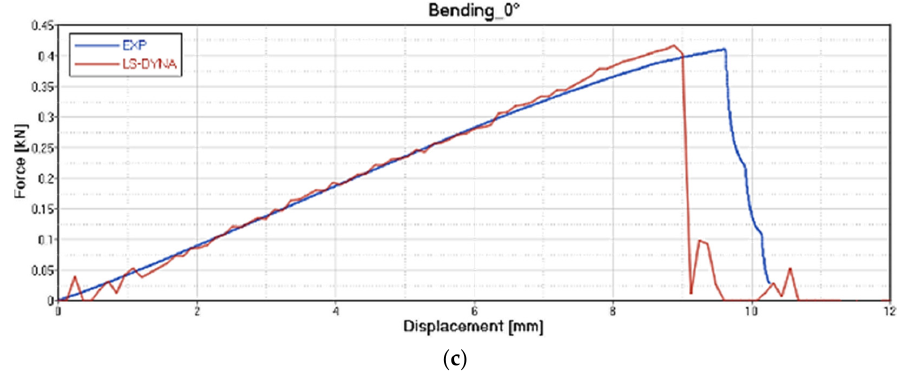
Figure 23. Correlation between experimental data and virtual material card setting for CF/EP-Solvay. Tensile test at 0° (a ); Tensile test at 45° ( b ) and Force-Displacement (kN-mm) for Bending test at 0° ( c ).